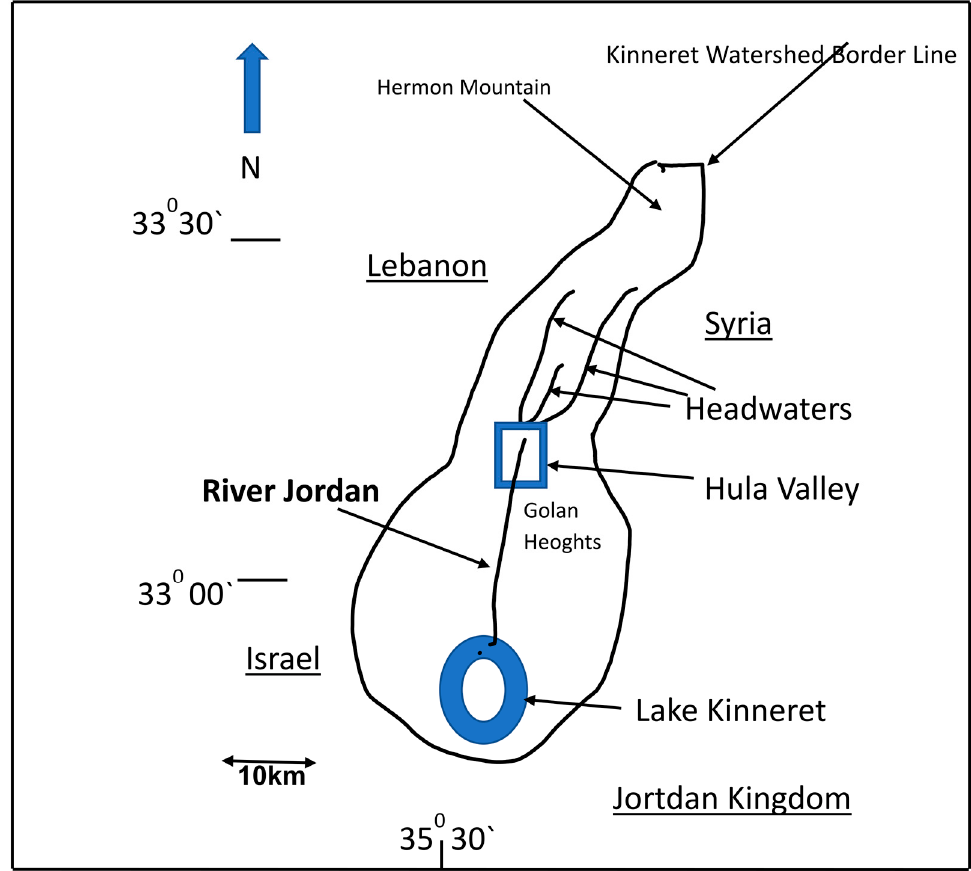
Figure 1. Geographical chart of the Lake Kinneret Watershed. River Jordan, three major headwaters, (Dan, Snir, and Banyas), Longitude and latitude location, Lake Kinneret, the Hula Valley and geopolitical territories are indicated